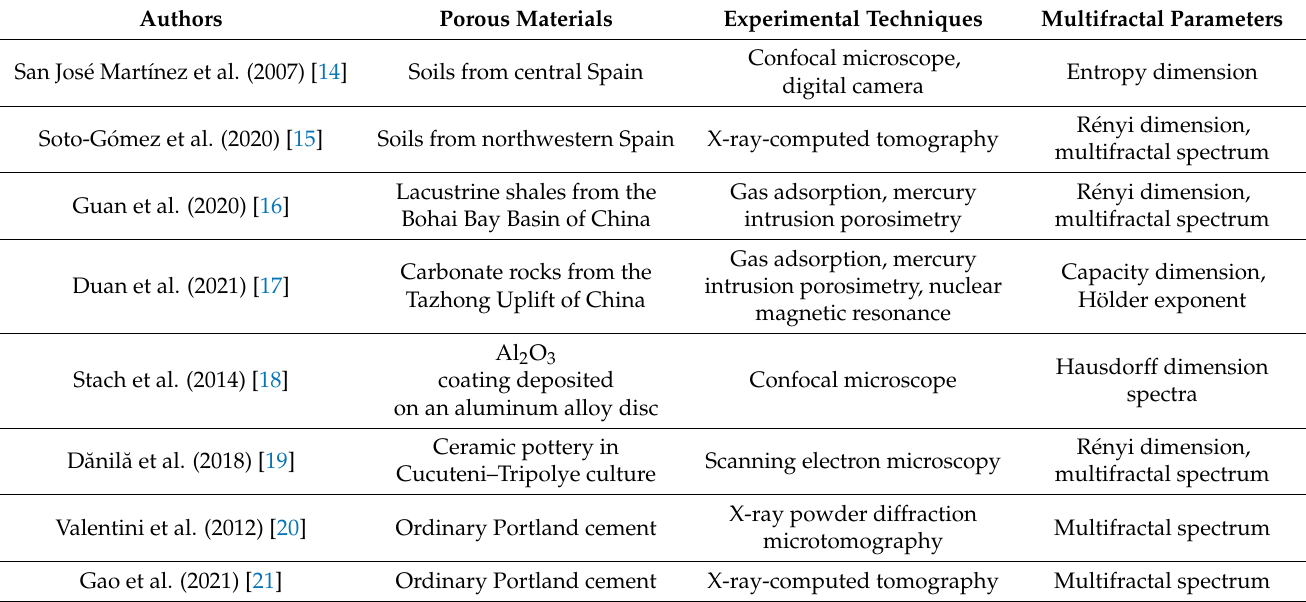
Table 1. Previous works examining the multifractal characteristics of inorganic porous